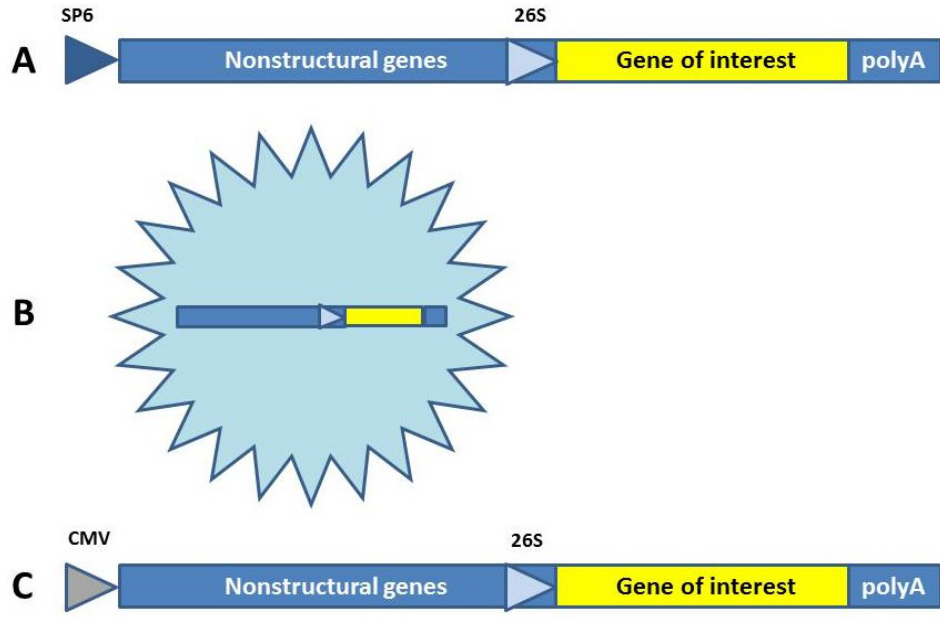
Figure 1. Alphavirus vector systems for vaccine delivery. ( A ) Naked RNA vector in vitro transcribed from plasmid DNA. ( B ) Replication-deficient alphavirus particles generated in baby hamster kidney (BHK) cells after co-transfection of in vitro transcribed RNA from the expression and helper vectors. ( C ) Layered DNA vector for plasmid immunization. SP6, polymerase promoter; 26S, subgenomic alphavirus promoter; CMV, cytomegalovirus promoter; polyA tail, polyadenylation